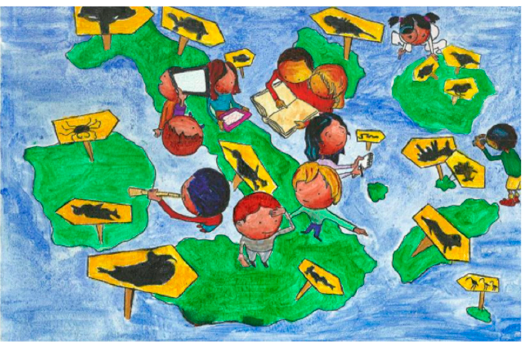
Figure 7. Realisation of the imaginations of movement from ideate to building.